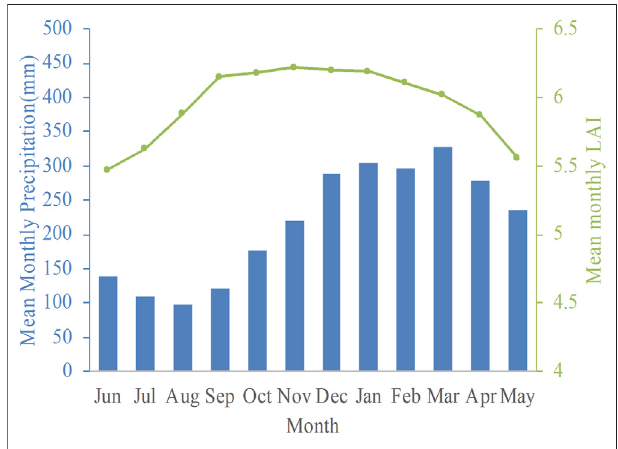
FIGURE 10 | Annual courses of monthly-average precipitation and LAI over the Amazonian central rainforest. Monthly data were accumulated over the time period February 2000 to December